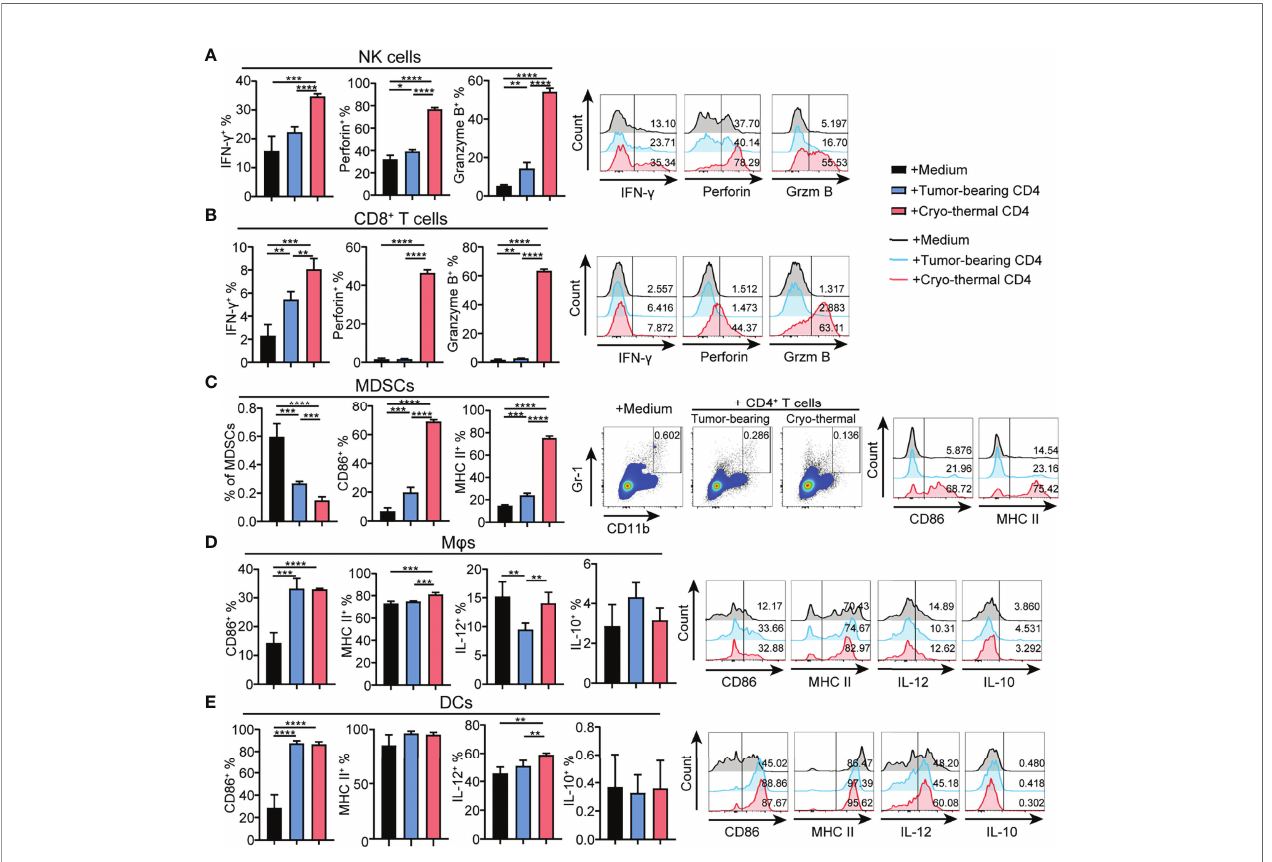
FIGURE 3 | Phenotype of immune cells cocultured with CD4 + T cells in vitro . Cryo-thermal CD4 - cells were cocultured with tumor-bearing or cryo-thermal CD4 + T cells, and immune phenotype of (A) NK cells, (B) CD8 + T cells, (C) MDSCs, (D) M j s and (E) DCs were analyzed. All data were shown as mean±SD. n =4 for each group. *P < 0.05, **P < 0.01, ***P < 0.001, ****P < 0.0001. Data for graphs were calculated by using two-sided Student ’ s